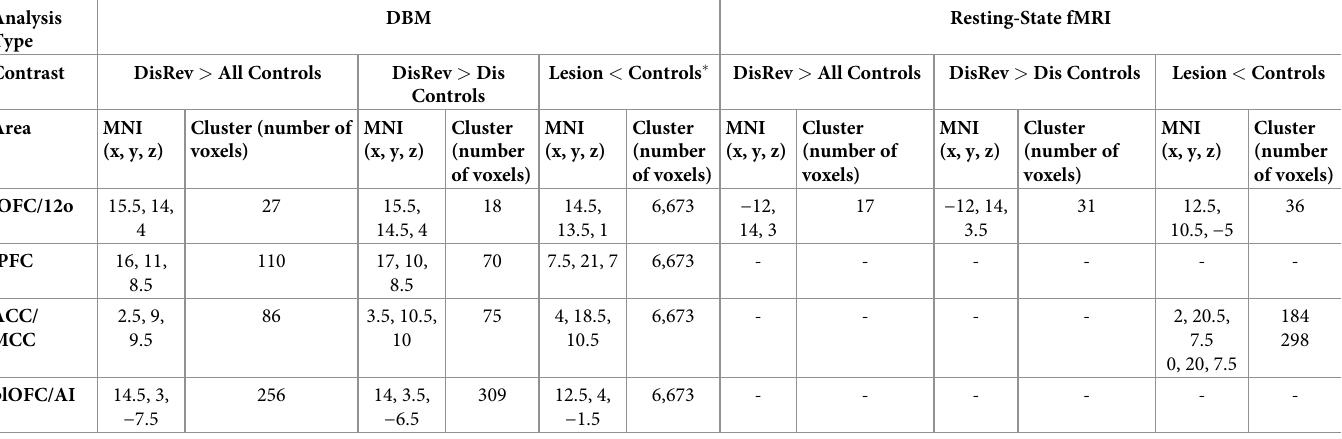
Table 1. Summary of the results (MNI coordinates and cluster size) across the four analyses (experiments 1 to 4) and two imaging methods (DBM or resting-state fMRI). Analysis Type